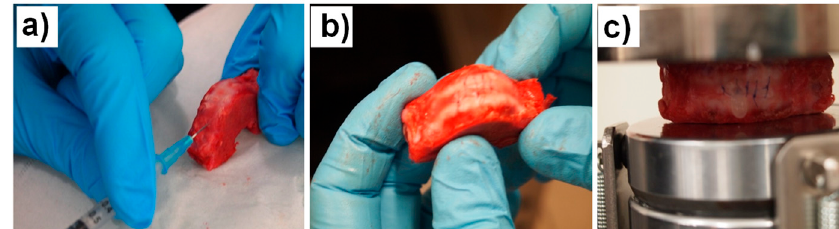
Figure 9. Appearance of discs after complete failure, which were subject to a treatment combination of CNF/CHI hydrogel (“gel state”) implantation in the disc annulus fibrosus region (Figure 2) and ( a ) injection of CNF/CHI viscous suspension (“sol state”) in the nucleus pulposus region. ( b ) Appearance after failure in a second mechanical testing, after already achieved failure in a previous compression test (Figure 8); the integrity of the disc was preserved at the hydrogel-implanted disc side. ( c ) The implanted hydrogel could not withstand a fluid leak during nucleus prolapse.